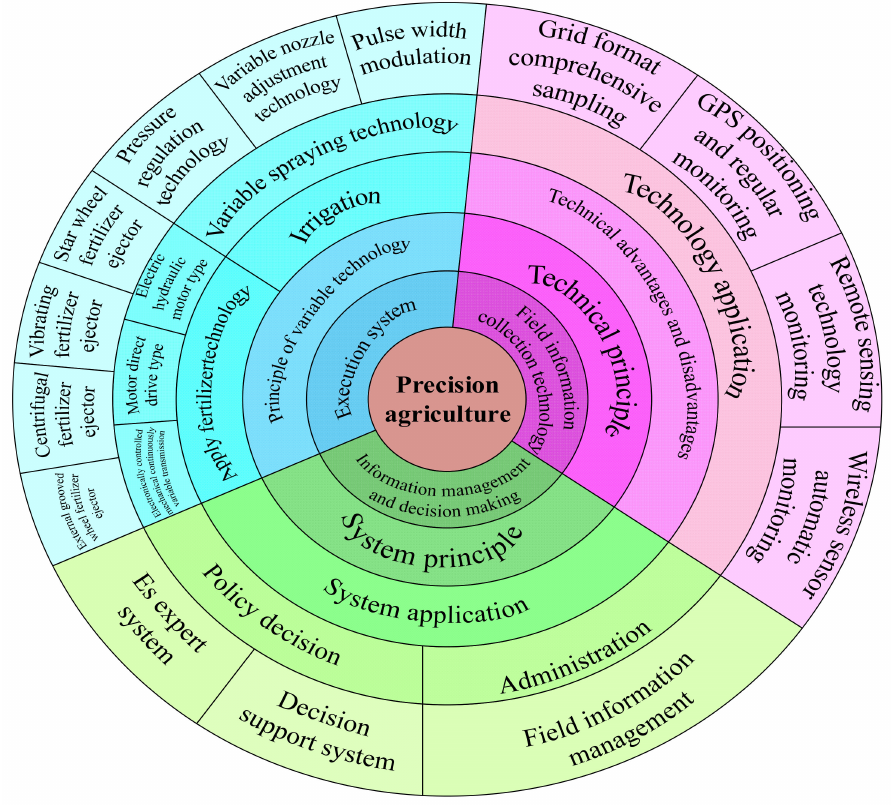
Figure 1. Article structure